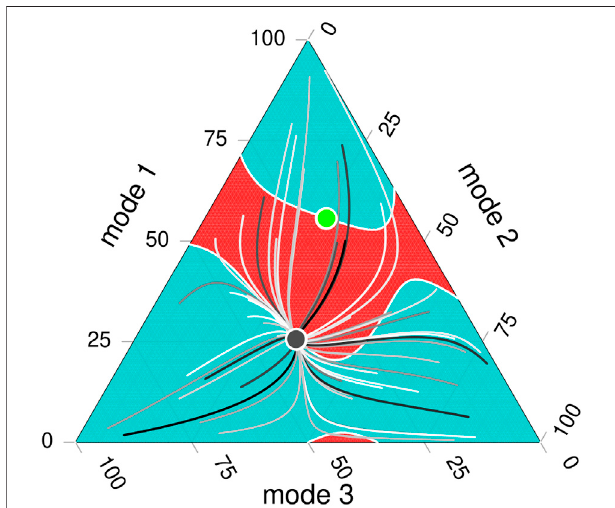
FIGURE 5 | Visualisation of the dynamics of the transport system for three different modes showing values of d μ and some trajectories which dt converge to the Nash equilibrium of the system. The dark disc is the equilibrium point x ° , and the green disc is the minimum commuting time < 0 are coloured in blue, such that the dynamics reduce x + . Values where d μ dt the average commuting times of the city as the dynamic evolves. The red > 0 in X region corresponds to values where d μ N . The red region thus dt representsthe tragedy ,whereeachpersonisminimisingtheircommutingtime but increasing the average. Fifty trajectories with distinct initial conditions are coloured in grey. When a trajectory passes through a red region, it increases its average commuting time.